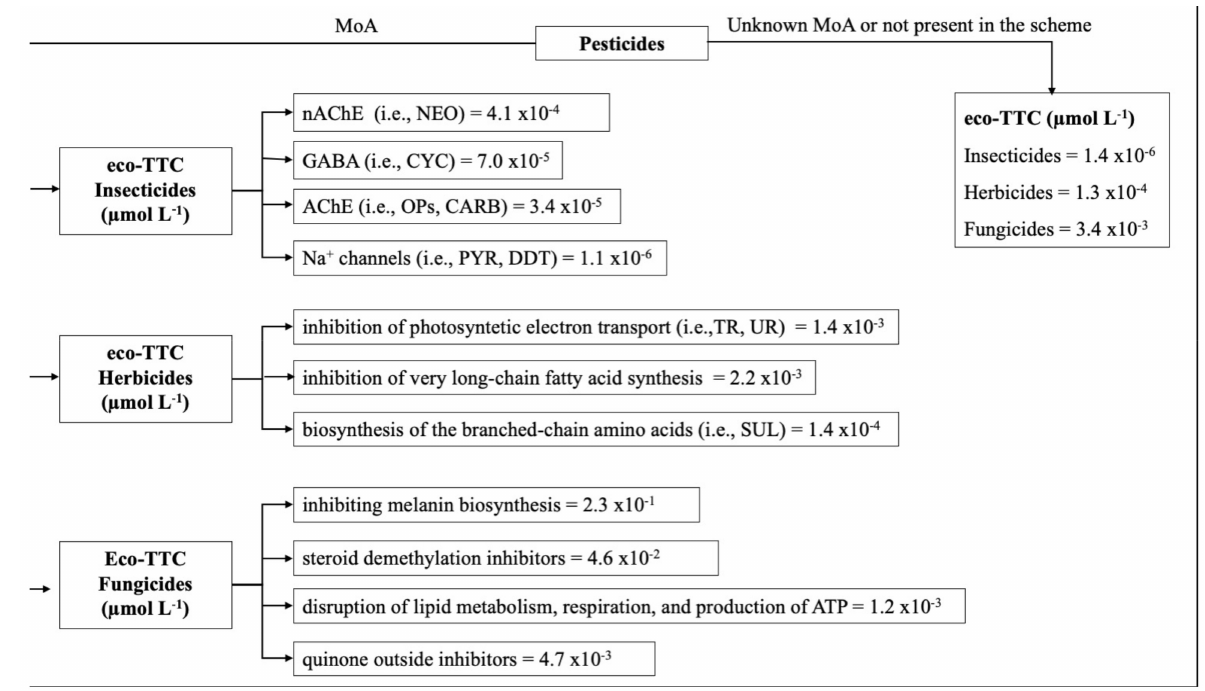
Figure 2. Tree diagram scheme to define eco-TTCs expressed in µ mol L − 1 for classes or groups of pesticides sharing the same mode of action. Table 3. Comparison of the calculated eco-TTC and literature data of HC 5 (expressed in µ g L − 1 and µ mol L − 1 ) and the eco-TTC assigned to classes of pesticides exhibiting the same mechanism of action according to this procedure scheme (eco-TTC values calculated using an AF =